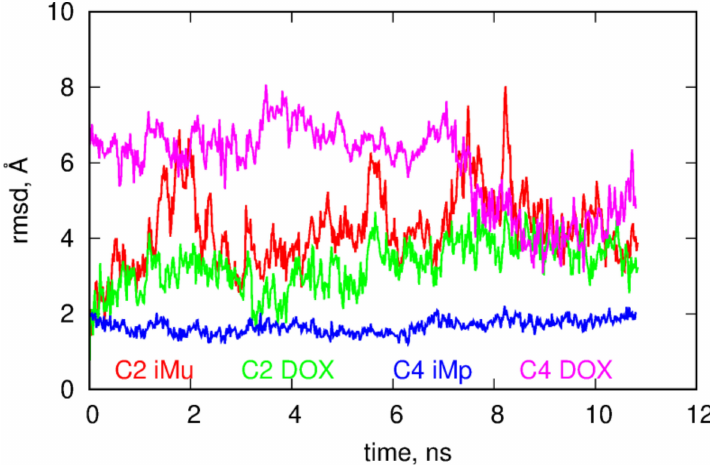
Figure 6. RMSD for components of the C2 and C4 systems. As the reference structure the states obtained in the previous 10.8 ns were